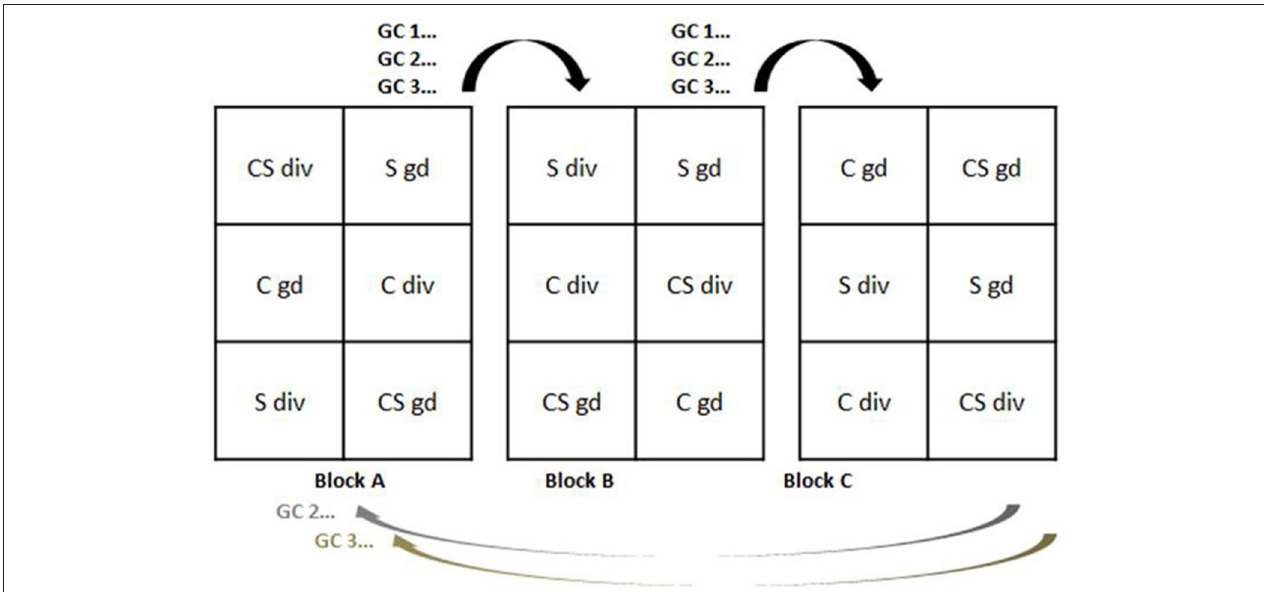
FIGURE 1 | Conceptual figure of the grazing management during each grazing season from 2007 until 2011. C, cattle; S, sheep; CS, mixed-grazing of cattle and sheep; div, diverse-sward; gd: grass-sward; GC 1-3, number of grazing cycle. Each paddock consisted of 0.5 ha area. During each grazing cycle, blocks were grazed successively with a total of six herds each arranged within the factorial combination of sward type × grazing system. Blocks were grazed successively without interruption. Each individual animal stayed within the same group of animals allocated on the same sward type within each year. TABLE 4 | Herbage mass (HM, t DM ha − 1 ), postCSH (cm), and concentrations of CP (% DM), ADF (% DM), and energy (MJ ME kg − 1 DM) as affected by sward type × grazing system for the experimental years 2010 and 2011. Sward type gd div